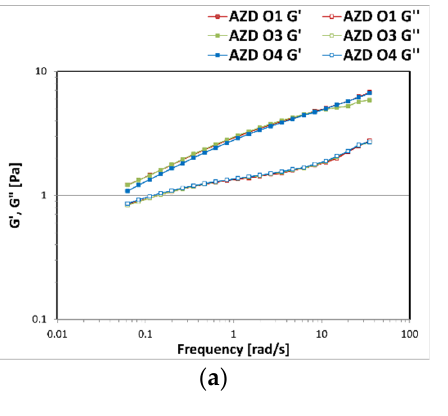
Figure 11. Storage G’ and loss G’’ moduli trend as a function of the oscillation frequency ( a ) and texture curves obtained from an immersion/de-immersion test ( b ) for the emulsions prepared with A-Z associations (ratio 1:1) at a total solid amount of 10% w/w, D at 0.1% w/w, and different oily phase O1, O3, and O4 at 10% w/w.